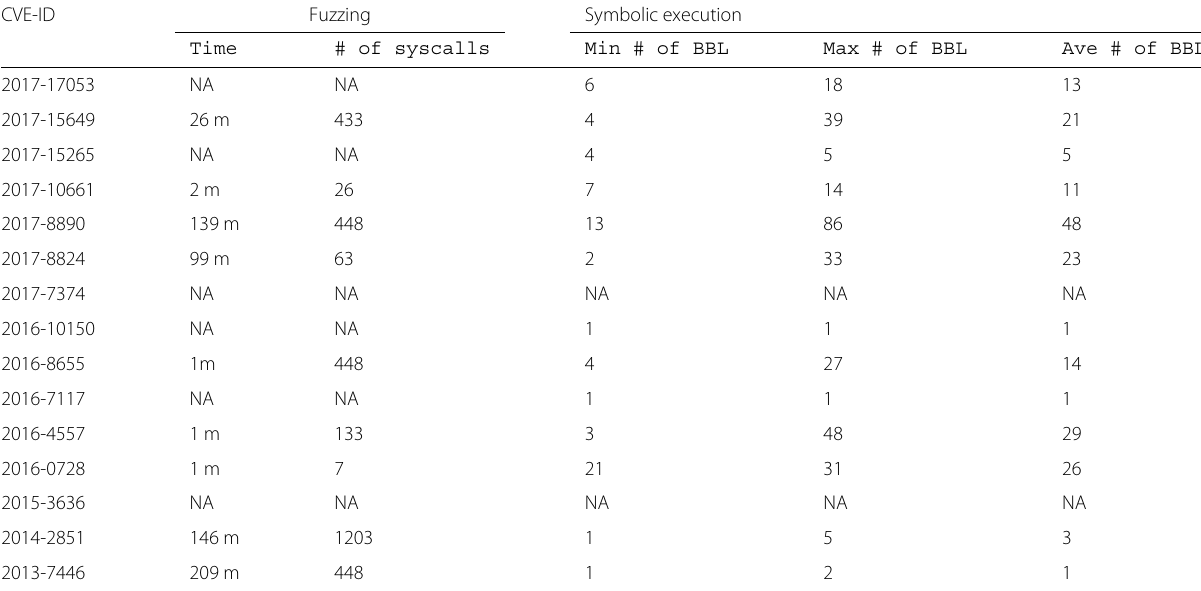
Table 4 The Efficiency of fuzzing and symbolic execution CVE-ID